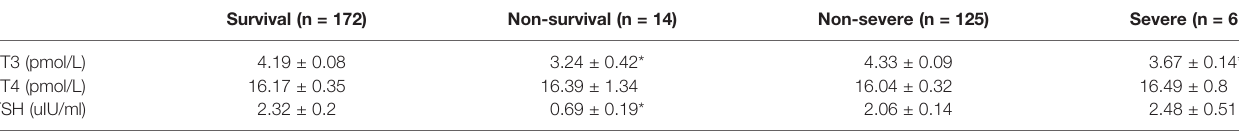
TABLE 1 | Thyroid function in different groups according to survival and disease severity.